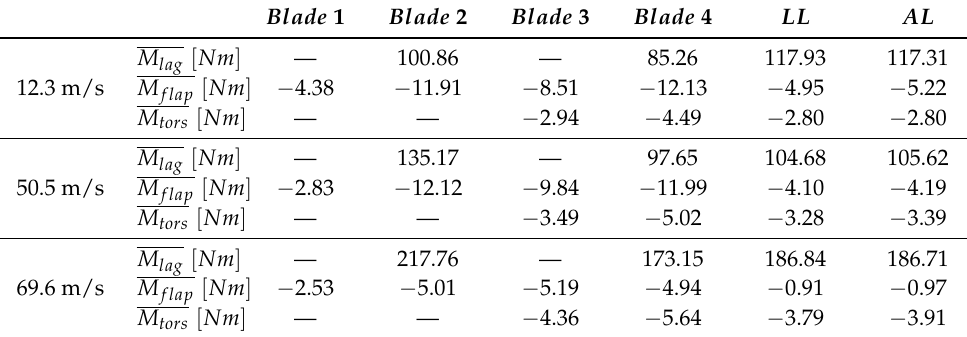
Table 12. Mean values of blade structural loads.